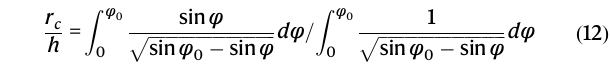
1 ffiffiffiffiffiffiffiffiffiffiffiffiffiffiffiffiffiffiffiffiffiffiffiffiffiffiffiffiffiffi